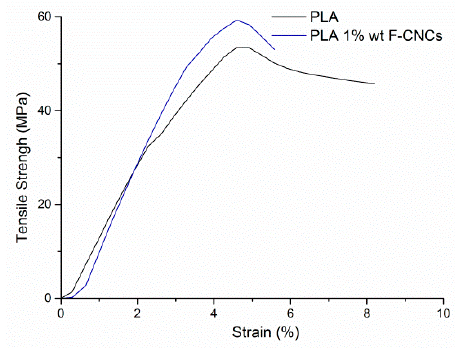
Figure 7. Representative stress-strain curves for neat PLA and 1% wt F-CNC reinforced PLA nanocomposite.